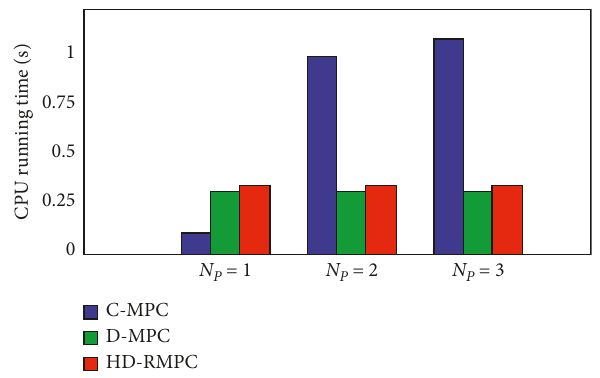
Figure 13: Average CPU running time of HD-RMPC and